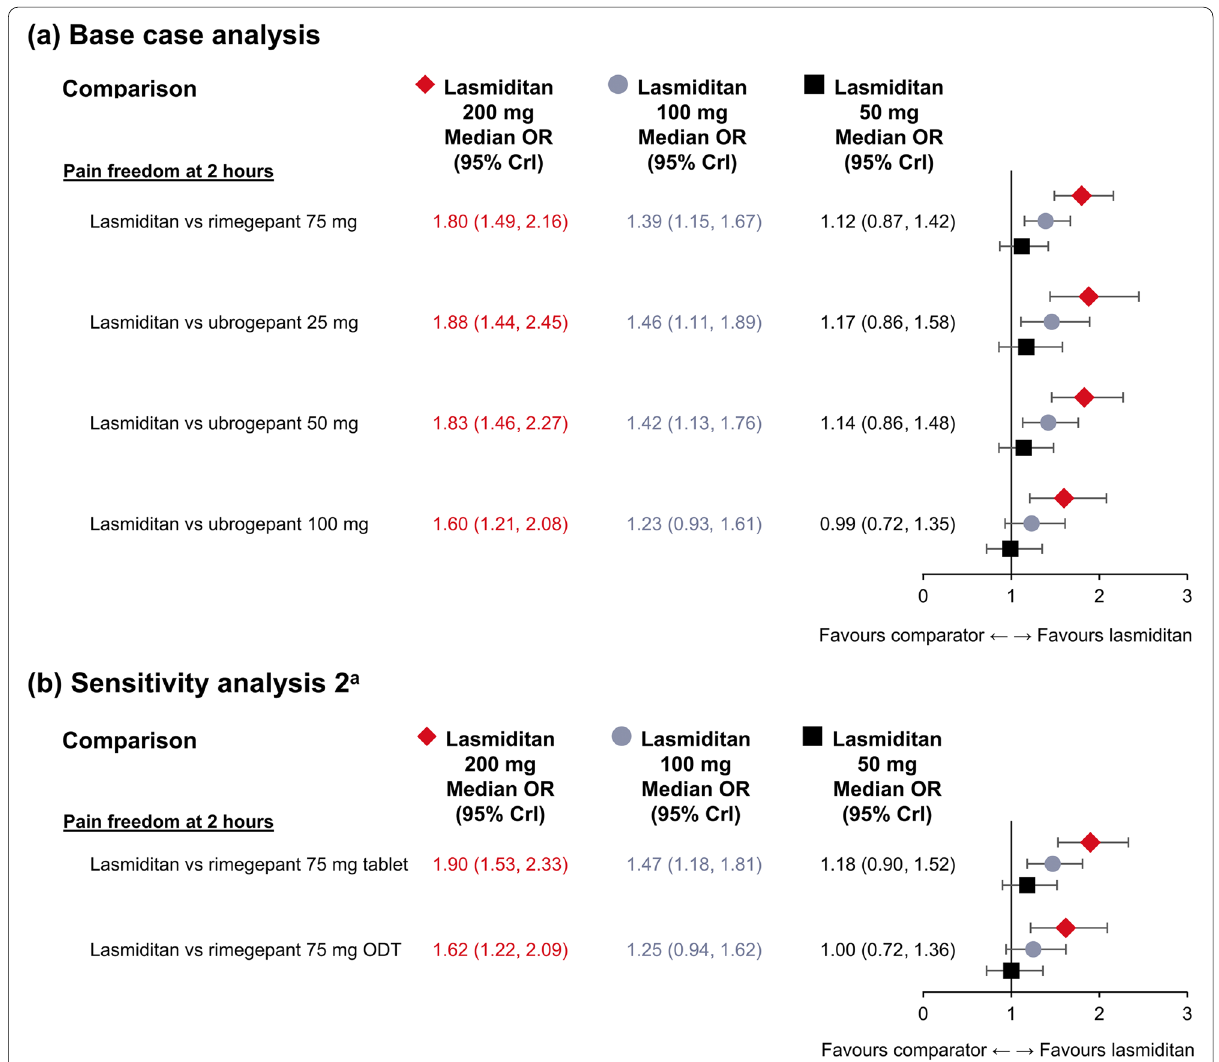
Fig. 3 NMA results for pain freedom at 2 hours. a Sensitivity analysis 2 analysed rimegepant according to its mode of administration (tablet or ODT). Pairwise treatment comparisons – results from Bayesian fixed-effects NMA adjusted for baseline risk ( base case analysis: 36 observations, residual